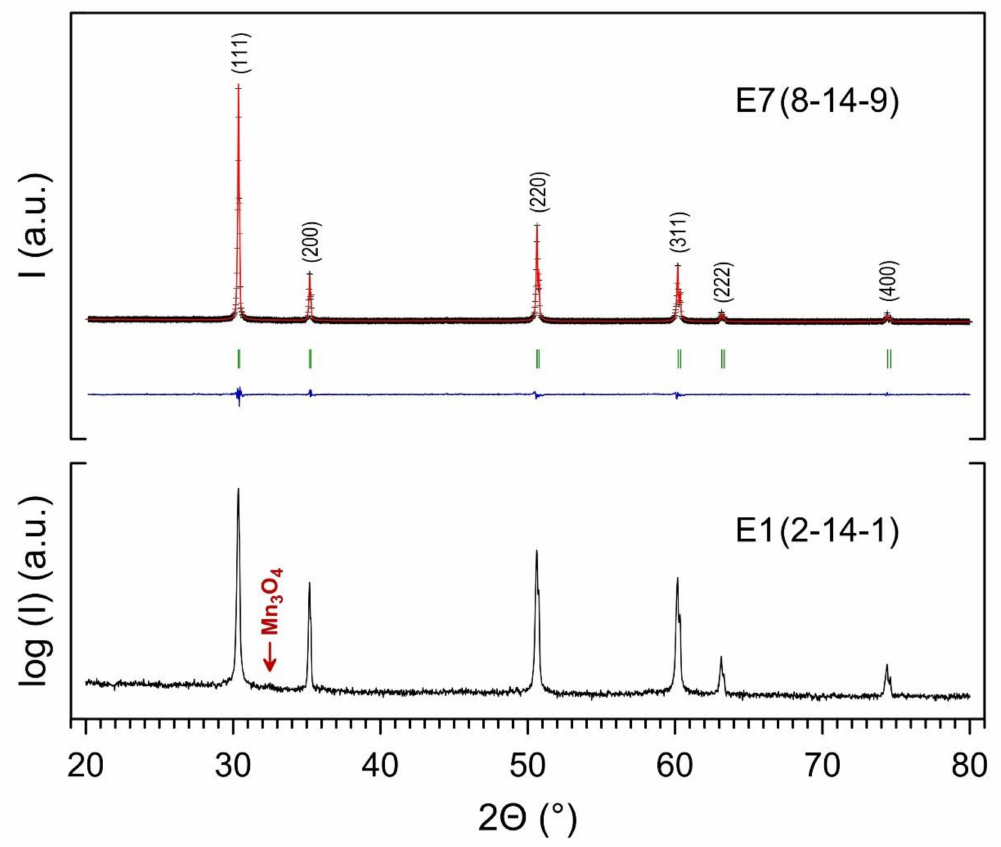
Figure 2. X-ray di ff ractograms of samples E1 (2-14-1) and E7 (8-14-9), sintered with firing schedules shown in Table 1. ( Bottom ): Relative intensity is shown in logarithmic scale to screen eventual traces of secondary phases. ( Top ): The cross symbols and the solid line (red) represent the experimental and calculated intensities, respectively, and the line below (blue) is the di ff erence between them. Tick marks (green) indicate the positions of Bragg peaks in the Fm 3 m space